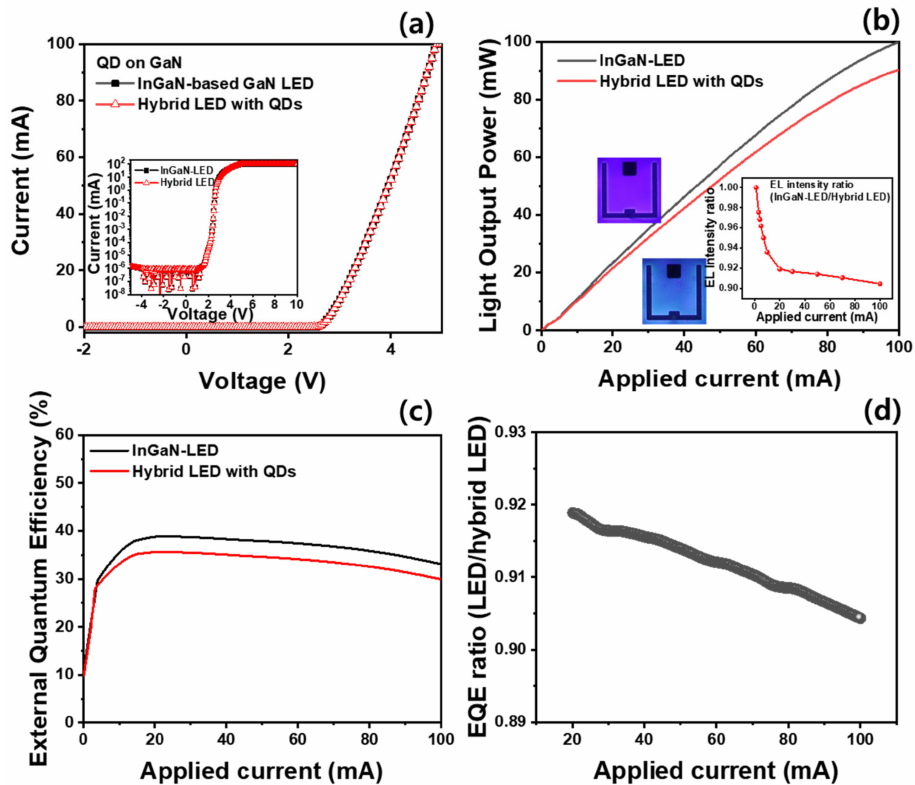
Figure 3. L–I–V characteristics of the InGaN-based and hybrid LEDs: ( a ) I–V curves, ( b ) light output power versus injection current, and ( c ) EQE of InGaN-based violet LED and hybrid LED with CsPbBr 3 QDs; ( d ) EQE ratio of InGaN-based violet LEDs to hybrid LEDs with CsPbBr 3 QDs as a function of the injection